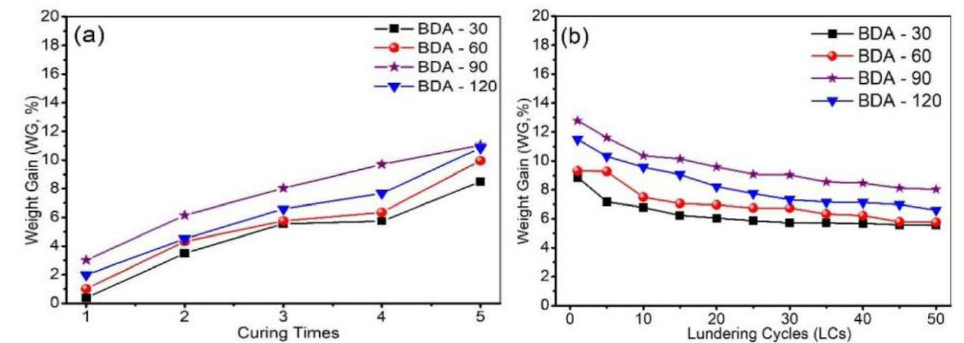
Figure 2. ( a )The relationship between weight gain (50 LCs) and curing times; ( b ) the relationship between weight gain (curing times) and laundering cycles.